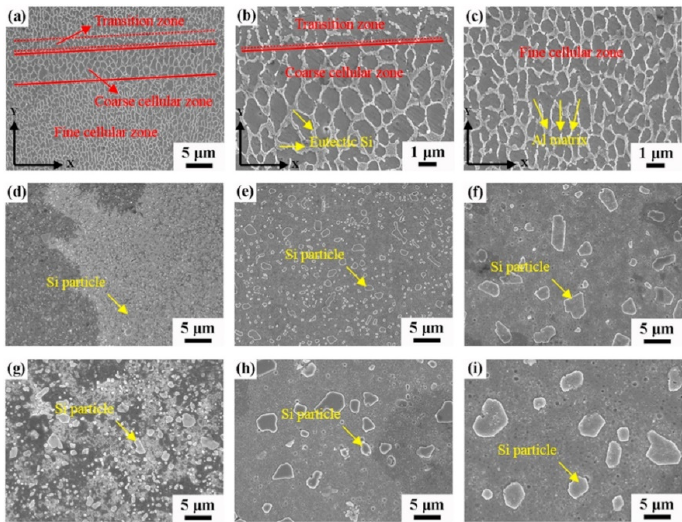
Figure 39. SEM images of AlSi10Mg SLM specimens after etching with Keller’s reagent ( a ) Single track melt ( b ) hatch boundary and ( c ) core of the hatch with fine cellular microstructure. SEM images of the AlSi10Mg microstructure after heat treatment under different conditions ( d ) 723 K for 2 h ( e ) 773 K for 2 h ( f ) 823 K for 2 h ( g ) 723 K for 2 h + 453 K for 12 h ( h ) 773 K for 2 h + 453 K for 12 h and ( i ) 823 K for 2 h + 453 K for 122 h [160]. Copyright 2016. Adapted with permission from Elsevier Science Ltd.